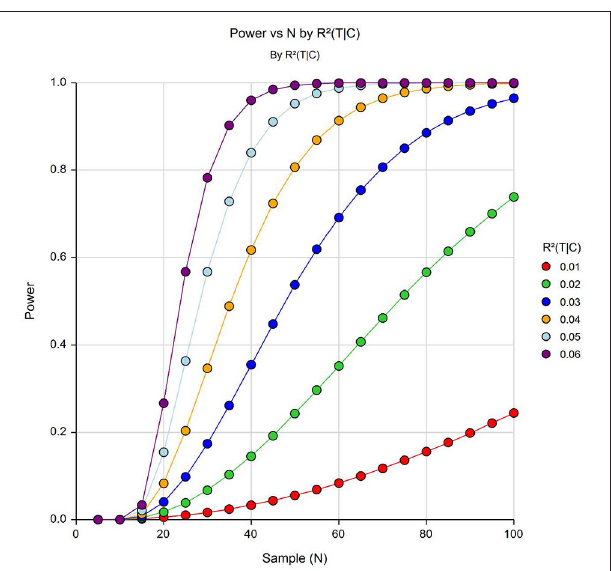
FIGURE 4 | Power to detect differentially expressed genes with varying effect sizes ( R 2 6C) at α = 5 × 10 − 4 . Y-axis shows power and the X-axis shows effective sample